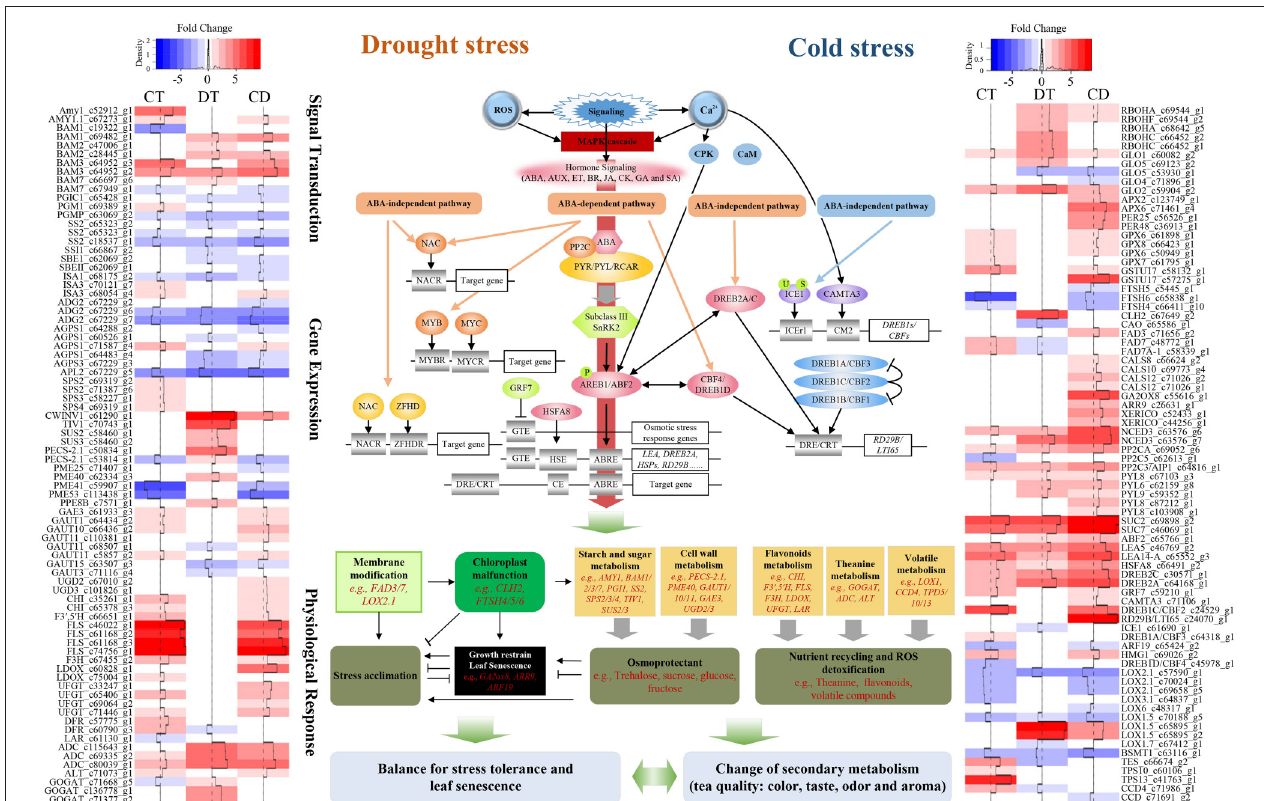
FIGURE 8 | Model representing the complex relationship between tea quality, leaf senescence and the responses to combined CD stress in C. sinensis . Sharp and blunt arrow denote activation and suppression, respectively. Heat maps show fold change of DEGs among the model during CT, DT, and CD. Full names of various genes are expanded in Supplementary Tables 11 , 13